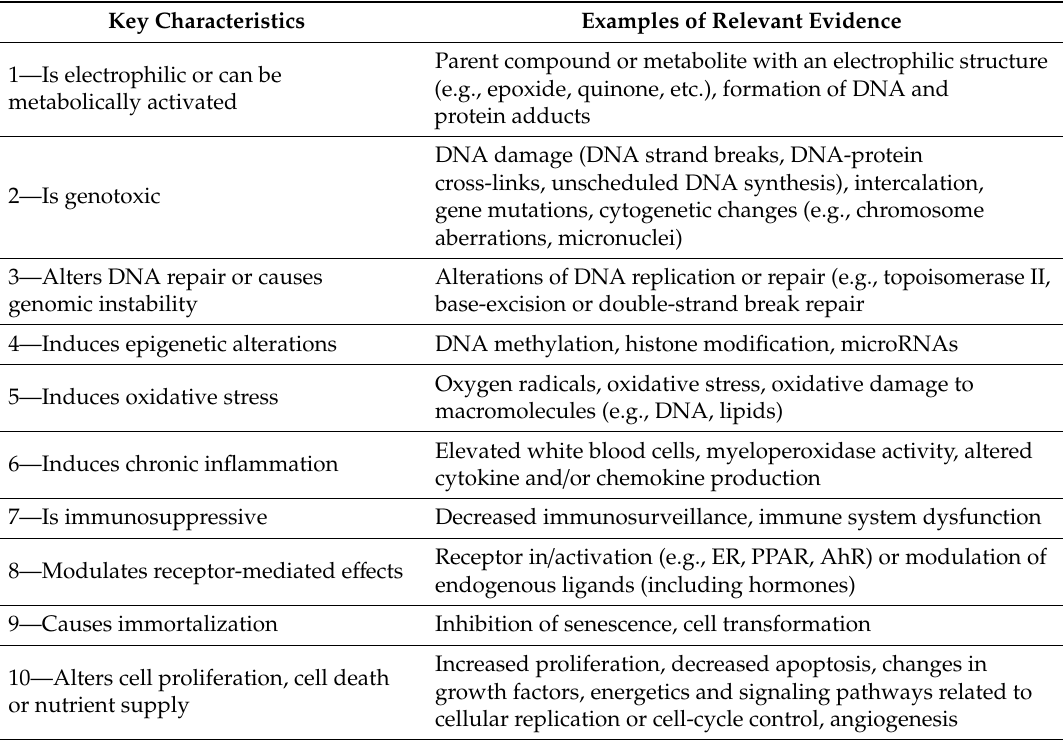
Table 1. The ten key characteristics of carcinogens a . Key Characteristics Examples of Relevant